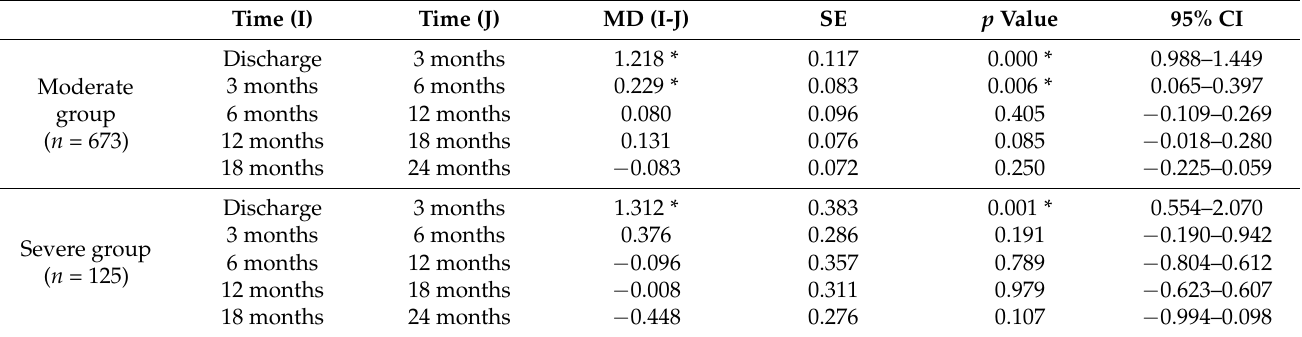
Table 2. Changes in the mean NIHSS total scores by time period for moderate and severe